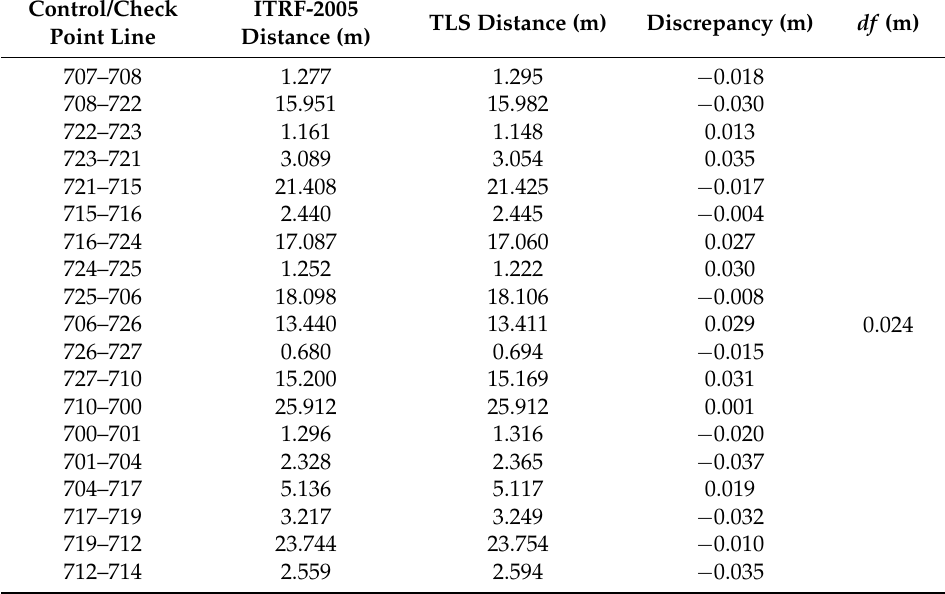
Table 3. The quality assessment criteria ( df ) for the inside 3-D point cloud model of the Mevlana